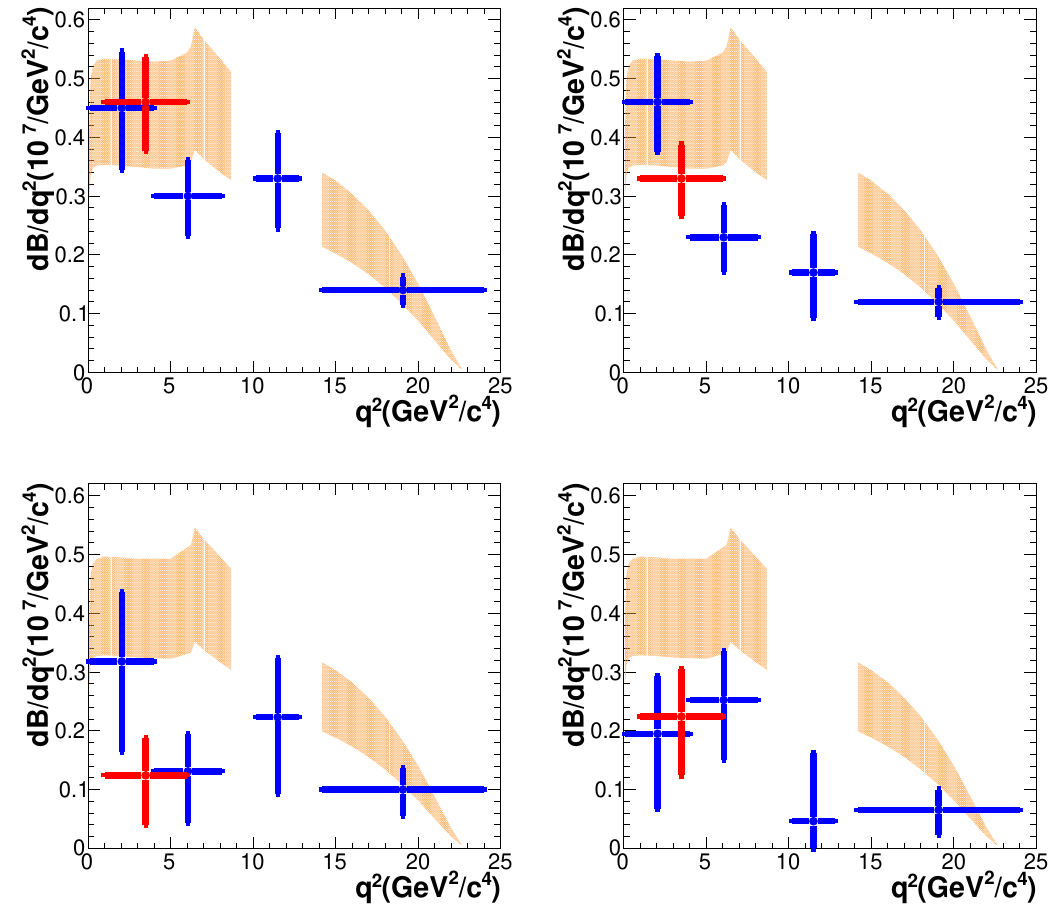
Figure 5 . d B /dq 2 measurements in bins of q 2 , for decays B + → K + µ + µ − (top-left), B + → K + e + e − (top-right), B 0 → K 0 µ + µ − (bottom-left), and B 0 → K 0 e + e − (bottom-right). The legends are the same as in figure 3. The yellow shaded regions show the theoretical predictions from the light-cone sum rule and lattice QCD calculations [41,